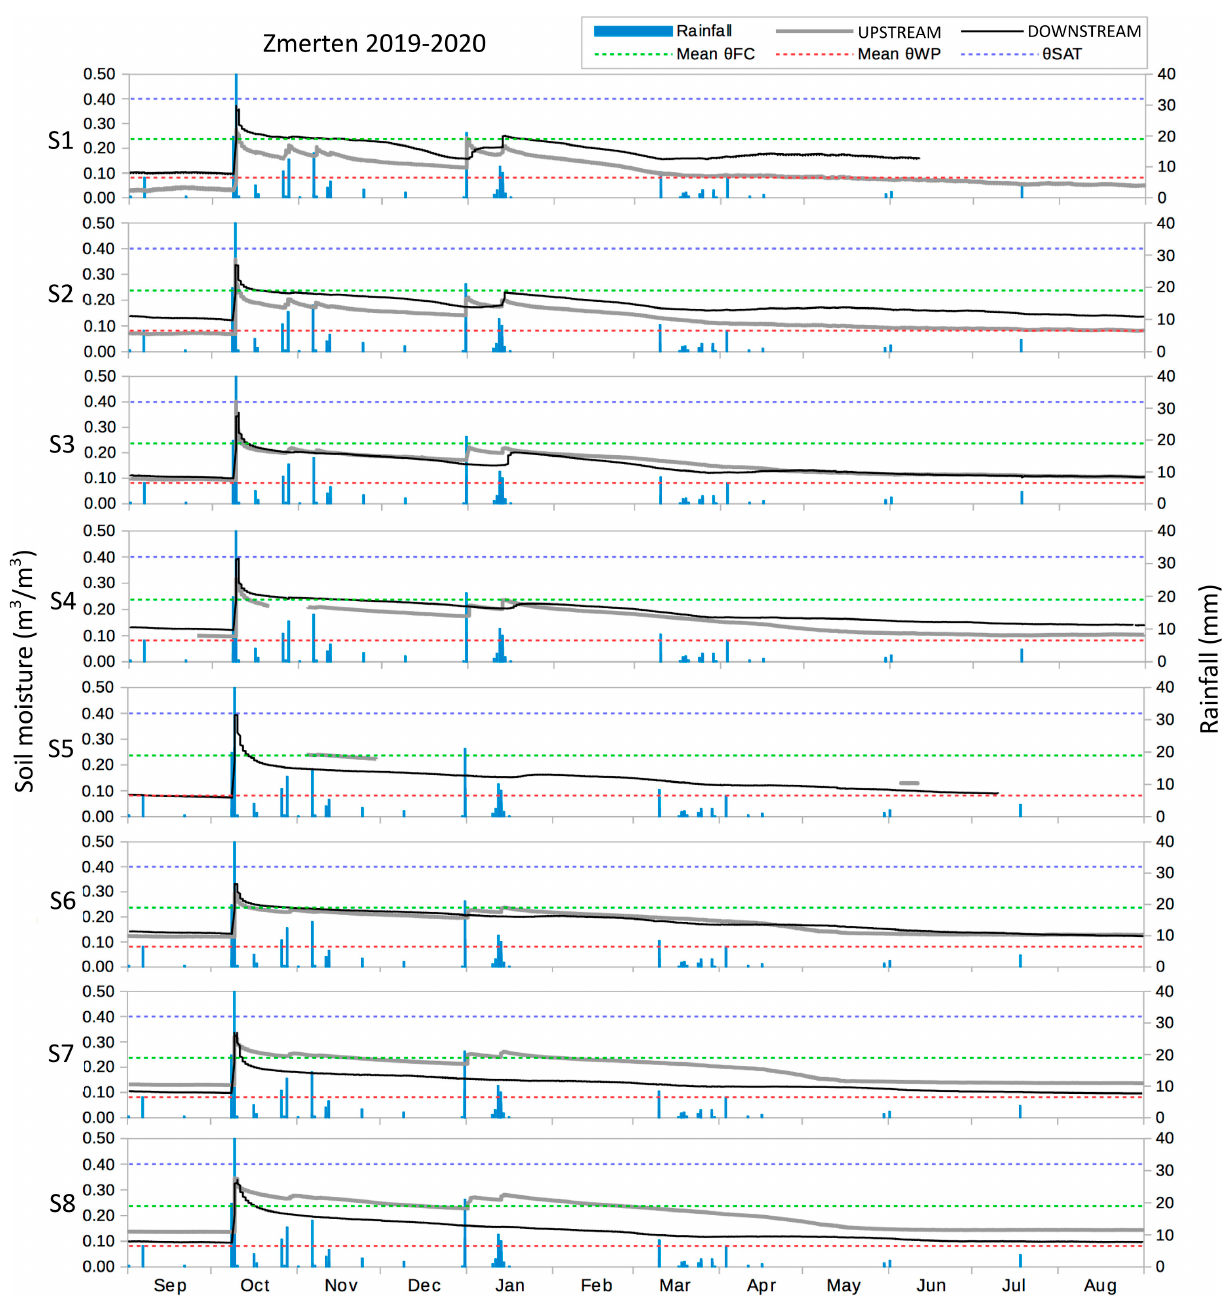
Figure 6. Evolution of soil moisture for the 8 sensors of upstream and downstream Jessour soil pro fi les (2019–20 agricultural year).